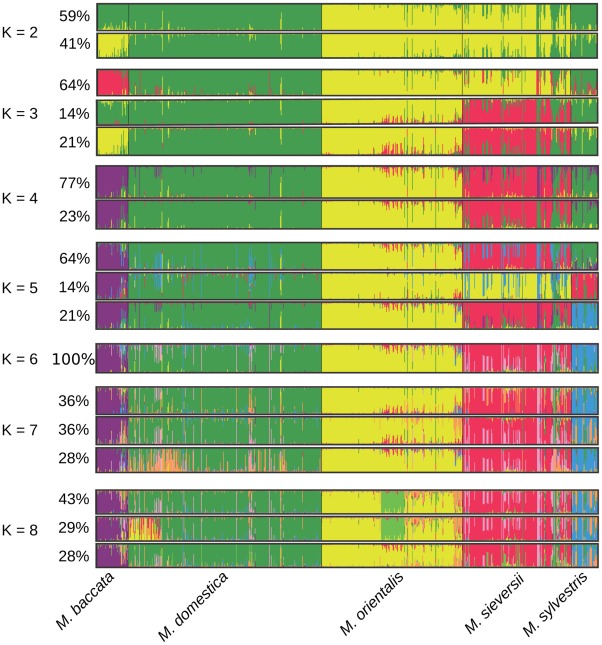
Proportions of ancestry of Malus genotypes from five species (N = 770) from K = 2 to K = 8 ancestral genepools (“clusters”) inferred with the STRUCTURE program.Each individual is represented by a vertical bar, partitioned into K segments representing the amount of ancestry of its genome in K clusters. When several clustering solutions (“modes”) were represented within replicate runs, the proportion of simulations represented by each mode is given.